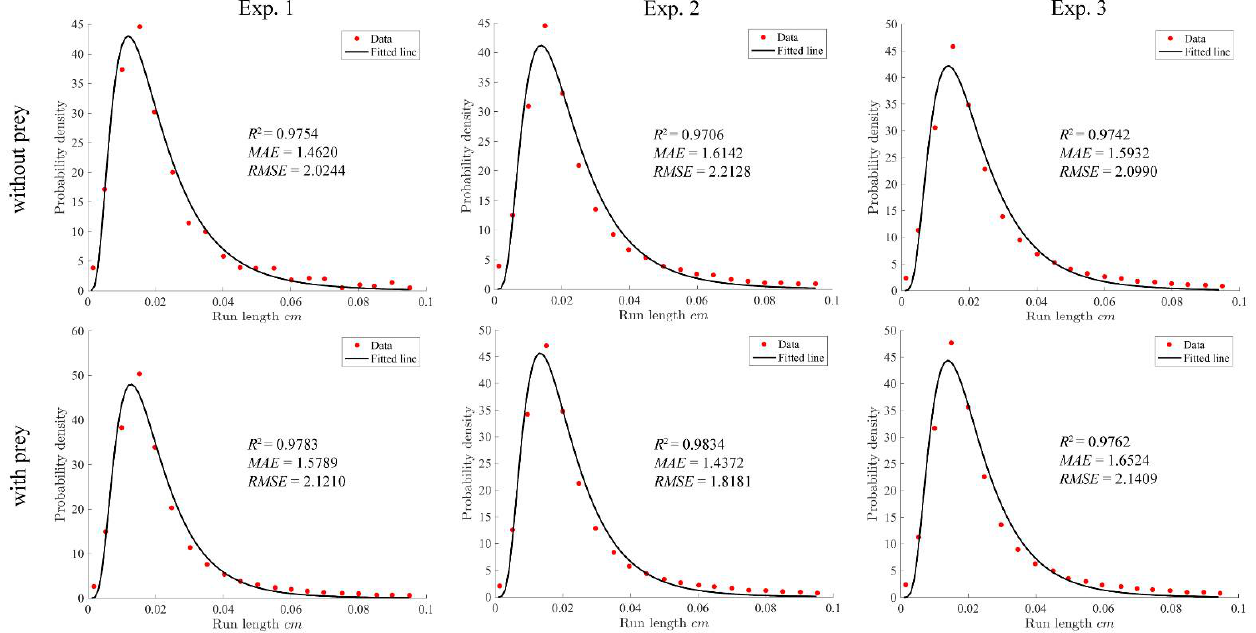
Figure 5. Fat tails in the frequency distributions of run lengths of O. marina before ( top ) and after ( bottom ) the introduction of a phytoplankton thin layer (Exp. 1 with either direct addition of the prey alga; Exp. 2&3 with cell-free filtrate). The red dots: original data; black line: fitted curve using log-normal distribution